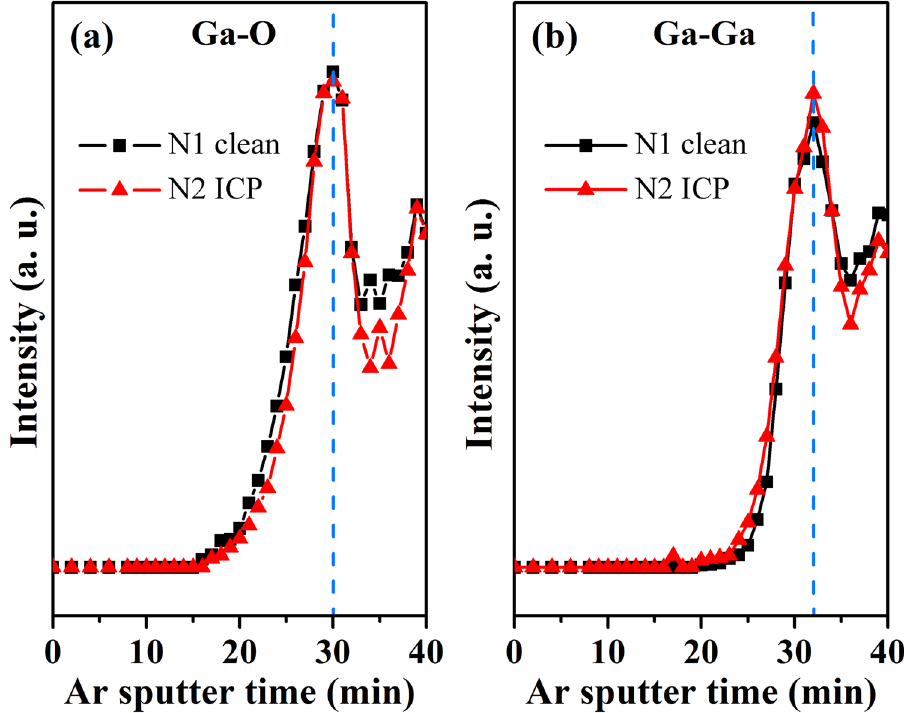
Figure 4. The depth profile of ( a ) Ga-O and ( b ) Ga-Ga component in Ga 3d core level spectra on N1, N2 samples.